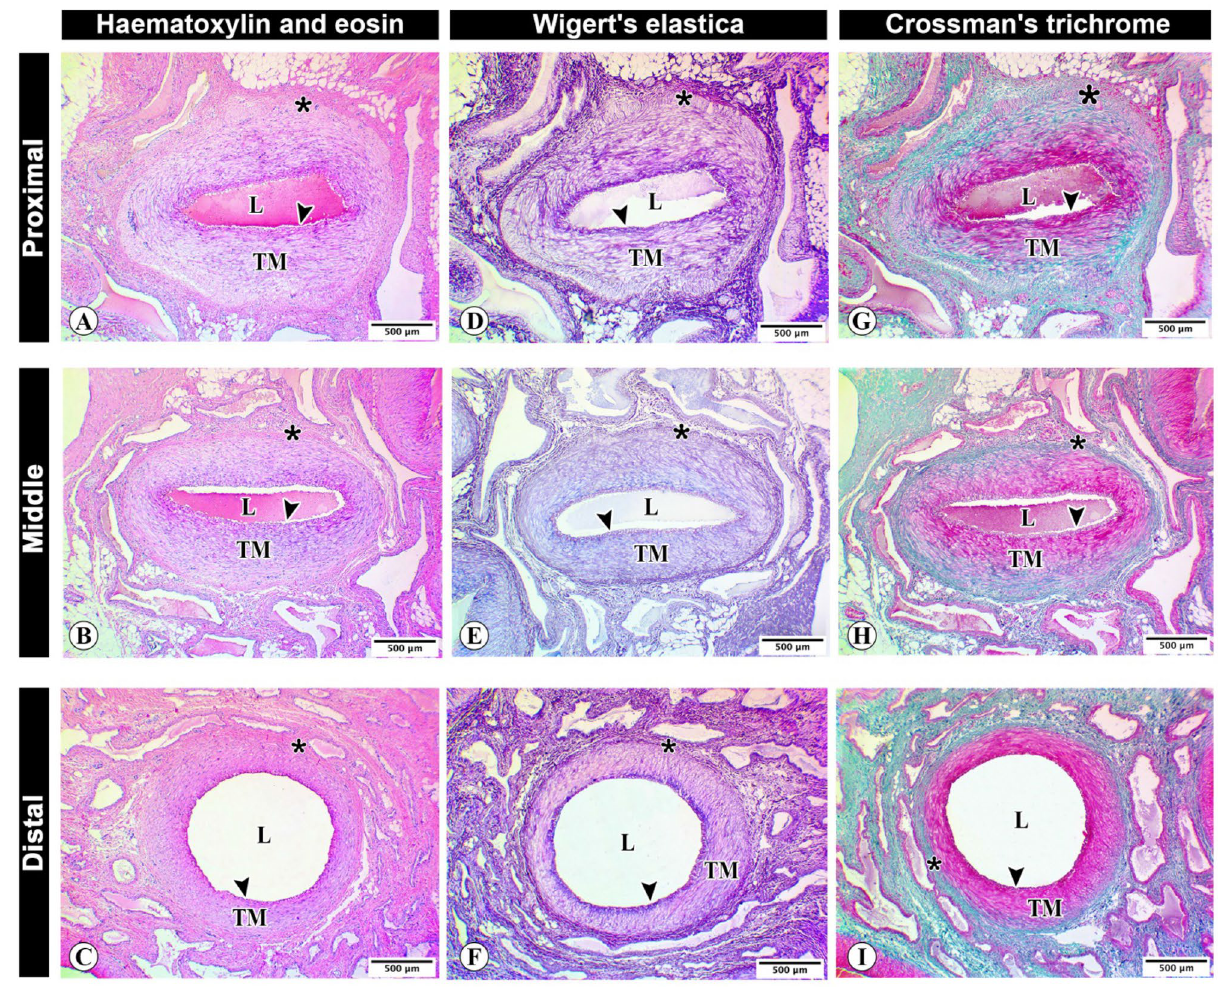
Figure 4. Histological architecture of the testicular artery wall. Photomicrographs of cross sections of proximal ( A , D , G ), middle ( B , E , H ), and distal ( C , F , I ) supratesticular zones of the testicular artery in the supratesticular region stained by H&E ( A – C ), Weigert’s elastic ( D – F ) and Crossmon’s trichrome ( G – I ) stains showing lumen of the testicular artery ( L ), tunica intima (arrowheads), tunica media (TM), and tunica adventitia (asterisks) with deposition of collagenous tissues (stained green with Crosson’s trichrome). Bar 500